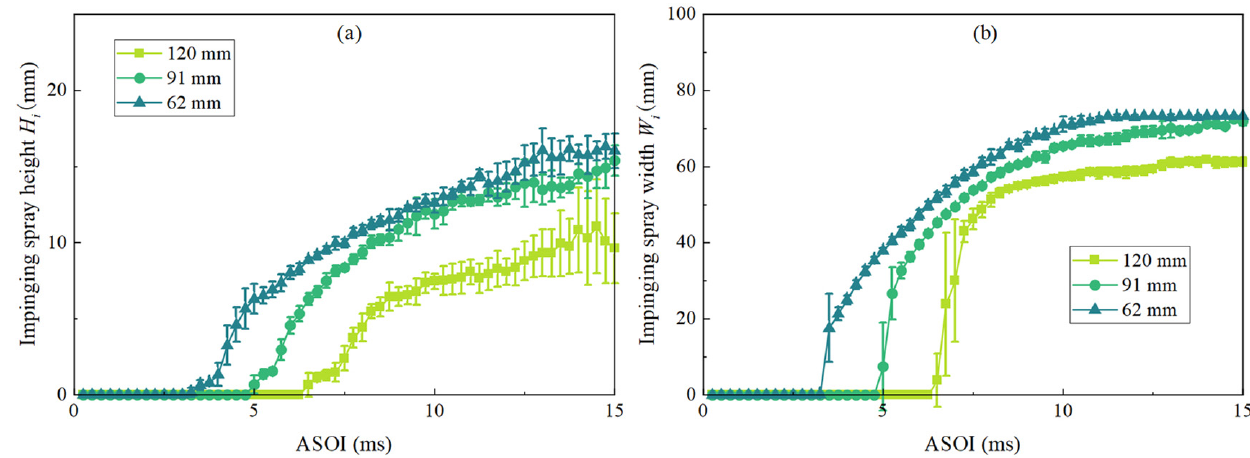
H and ( b ) width Figure 7. ( a ) Impinging spray height Figure 7. ( a ) Impinging spray height H i and ( b ) width W i of impinging spray under different D imp . i D . Figure 8 showed the impinging spray morphology under different wall temperature imp T wall (from 293 K to 423 K). The three sprays had a similar macro shape with various wall temperature conditions.